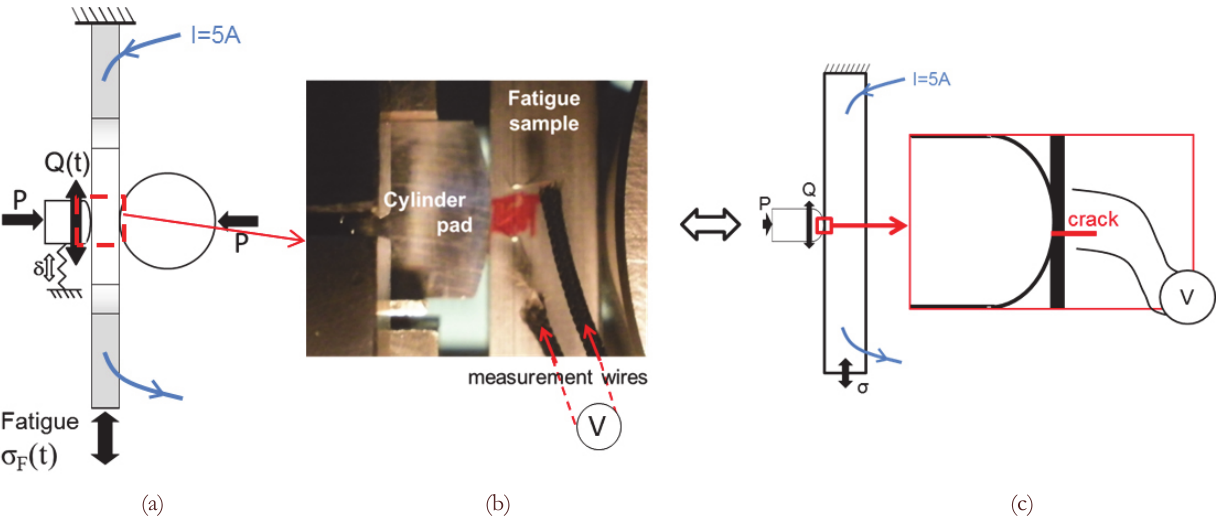
Figure 2: (a) sketch of the fretting fatigue test device, (b) Picture of the fretting fatigue contact with the measurement wires, (c) sketch of the implementation of the PDT